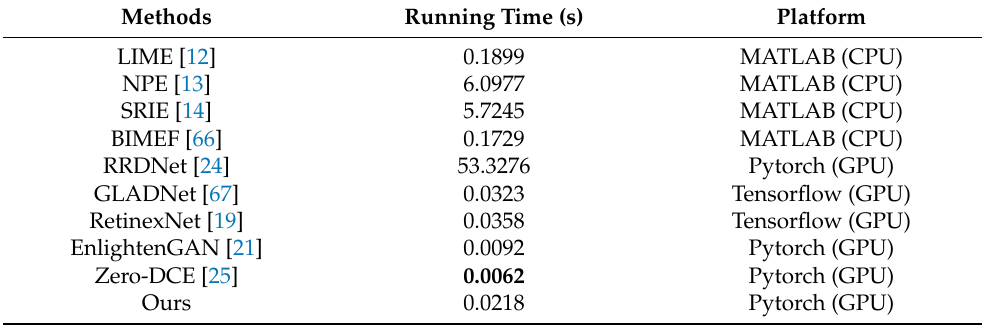
Table 6. Runtime comparisons of different methods. The best result is highlighted in